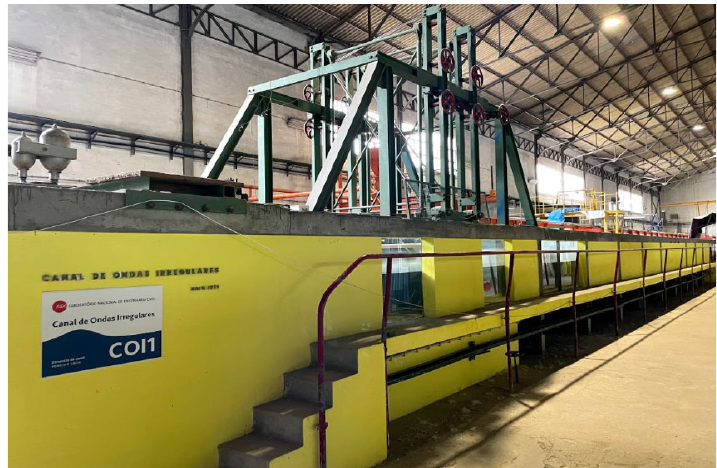
Figure 1. Overview of the irregular wave flume COI1.